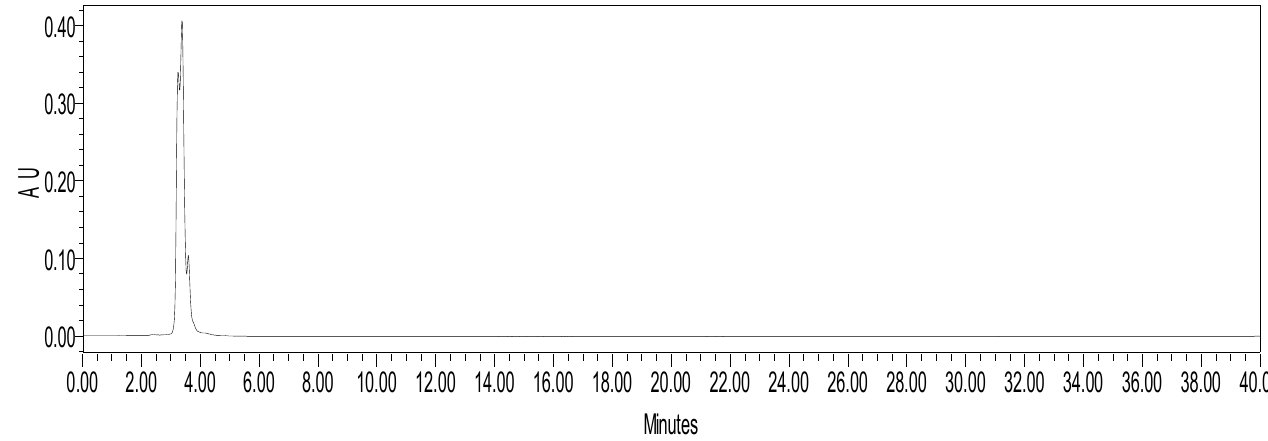
Figure 2. HPLC-DAD chromatogram at 355 nm, using a mobile phase gradient and a reversal phase C18 column, showing hispiduloside at retention time 3.897 min.